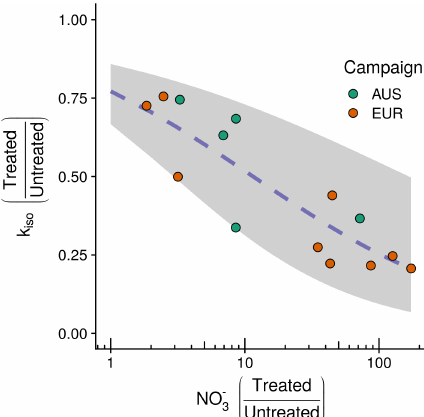
Figure 5. Observed negative relationship between the fractional change in the rate of oxygen isotope exchange ( k iso ) and the frac- tional change in exchangeable NO − between treated and untreated 3 soils following NH 4 NO 3 addition for the 14 sites considered. Plot- ted points indicate the change for individual sites with the associate sampling campaign indicated by colour (EUR: orange, n = 9; AUS: green, n = 5). On the y axis, quotients below 1 indicate that k iso in soils receiving the treatment decreased relative to corresponding un- treated soils for each site. On the x axis, quotients above 1 indicate that NO − availability in soils receiving the treatment increased rel- 3 ative to corresponding untreated soils for each site. The blue dashed line shows the fit of the minimal adequate generalised linear model describing the change in k iso with 95% confidence intervals shaded in